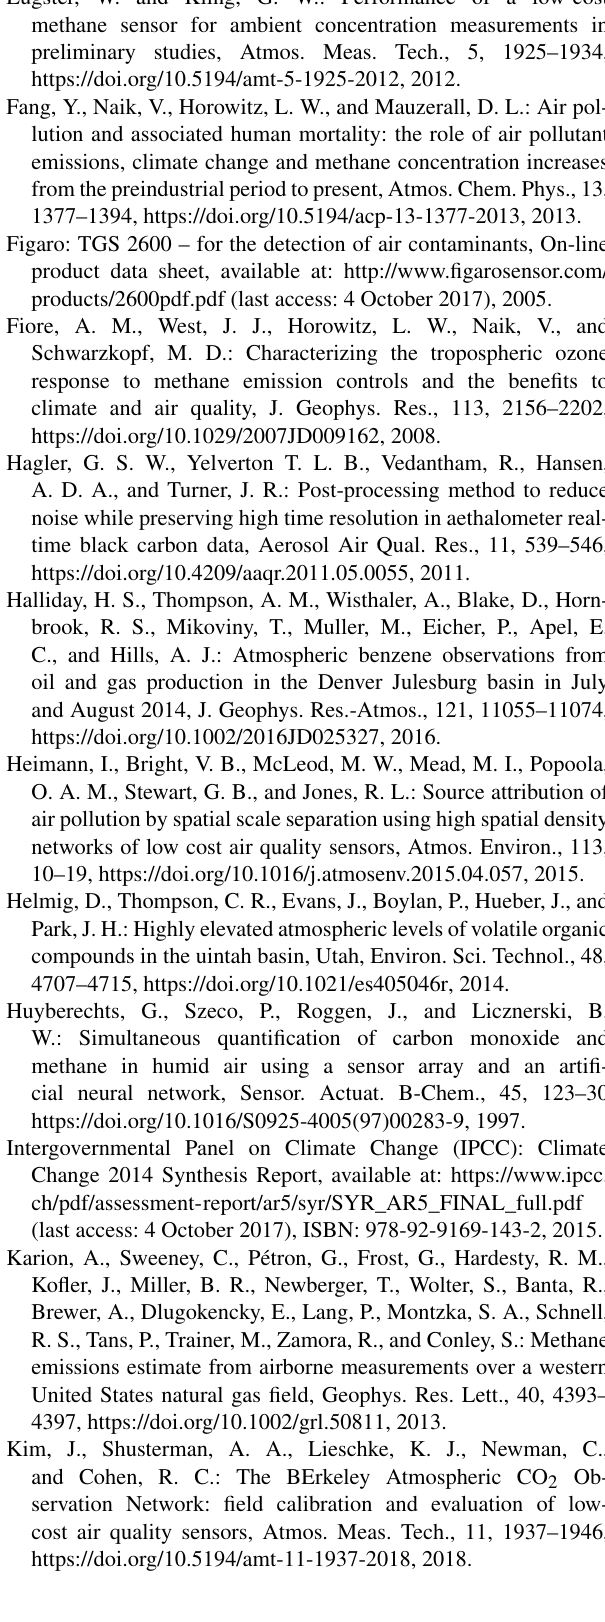
Figaro: TGS 2600 – for the detection of air contaminants, On-line product data sheet, available at: